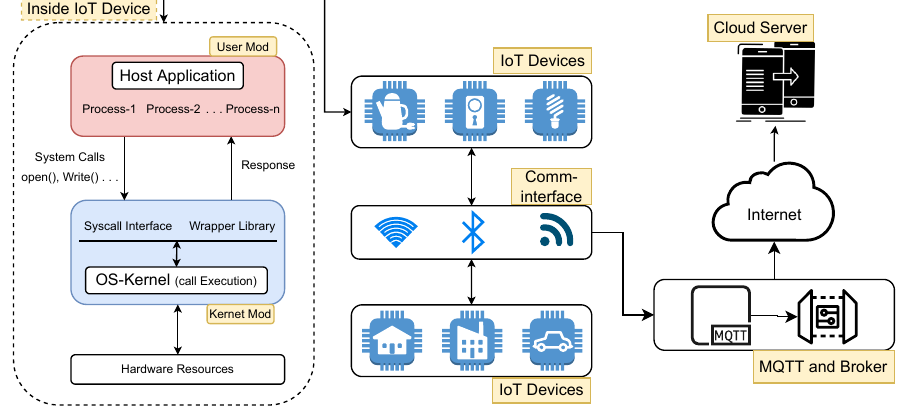
Figure 1. Abstract view of the IoT and system calls